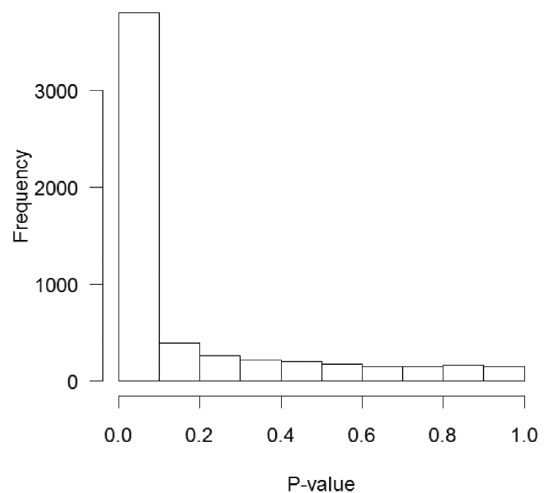
Figure 1. Frequency histogram of p -values. doi:10.1371/journal.pone.0063249.g001 PLOS ONE |